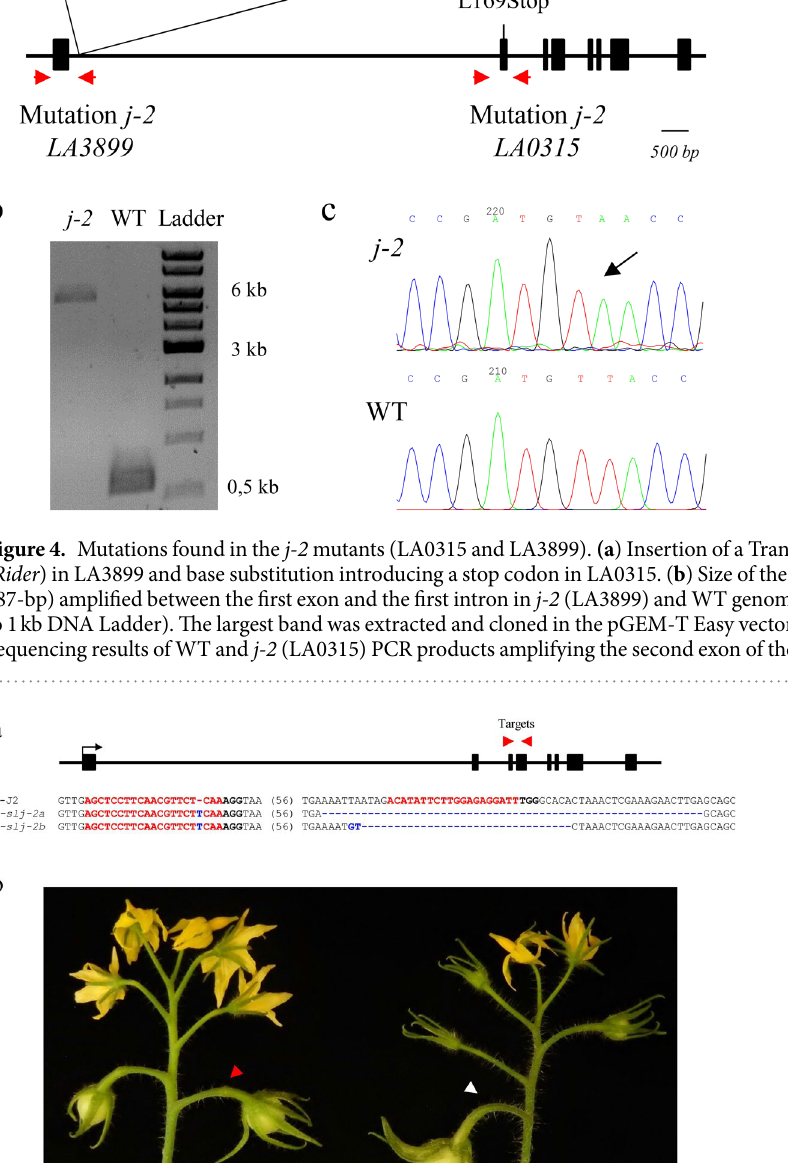
epistatic to j-2 (Fig. 7b). Fruits were also elongated as observed in the distal part of the truss of the j-2 (LA3899) and sometimes in j-2 (LA0315) mutants (Supplementary Fig. 1b, 2a). Expression data confirmed down-regulation of J in the single j mutant, and of J and J-2 genes in double j j-2 mutant, whereas expression of MC was similar to WT in both j and j j-2 mutants (Fig. 7c and d). Nevertheless, fruits of CR- slj-2 lines did not show elongated form (Fig. 5), indicating that this phenotype does not result from the loss of function of J-2 .